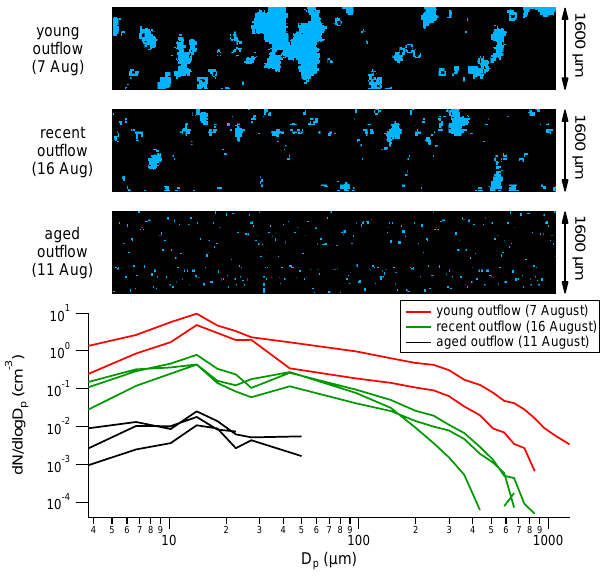
Fig. 19. Summary of outflow size distributions of the three flights on 7, 11, and 16 August 2006. Additionally, examples of consecu- tive CIP particle images for each outflow age are displayed on top starting with the youngest